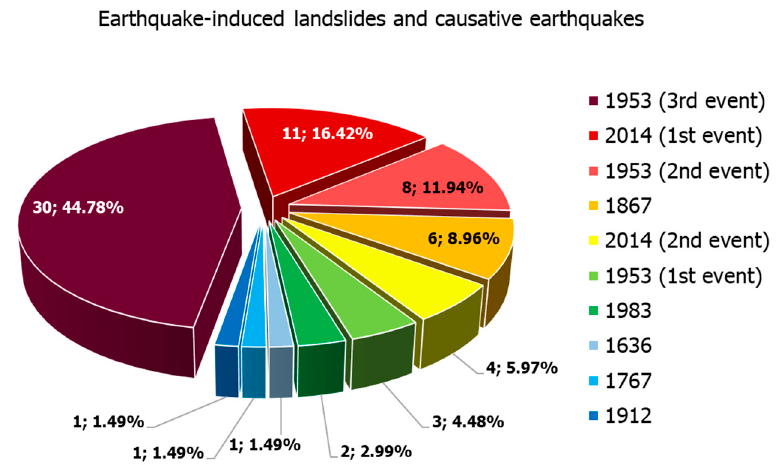
Figure 12. Pie charts showing the number and percentages of landslides triggered in Cephalonia Island by earthquakes from 1636 to 2014. The majority has been generated by the 1953 earthquake sequence.